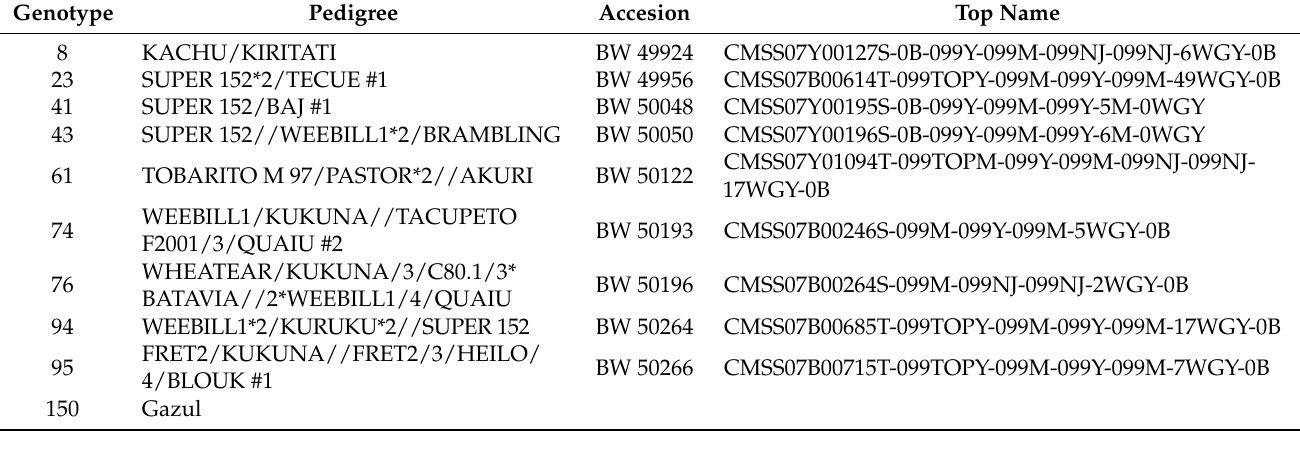
Table A1. Catalogue of the 10 wheat genotypes employed in the present study. Pedigree, accession code and top name of genotypes belonging to the Heat Tolerance Wheat Screening Nursery (8HT HTWSN) collection of the International Maize and Wheat Improvement Centre (CIMMYT) are provided.